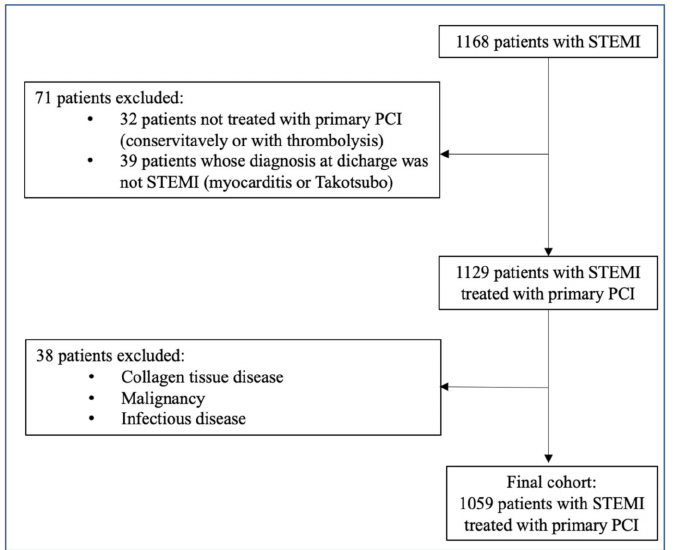
Figure 1. Inclusion and exclusion criteria. PCI—Percutaneous coronary intervention, STEMI—ST elevation myocardial